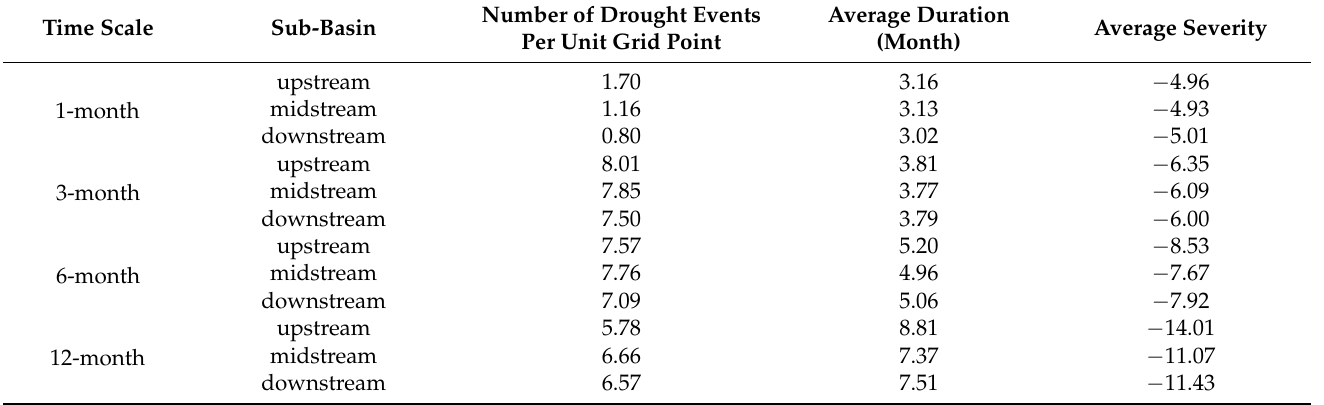
Table 3. Variable Statistics of Drought Characteristics in sub-basins of the Yangtze River basin,